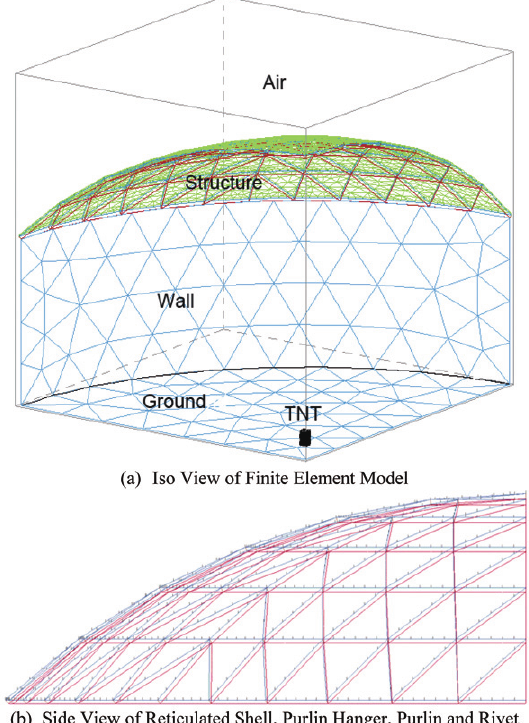
Fig. 5. Finite element model of the